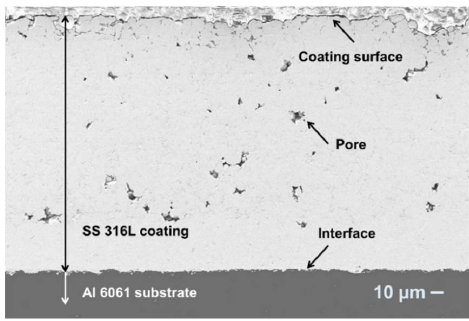
Figure 2. Cross–sectional SEM micrographs of cold sprayed stainless steel 316L coating.